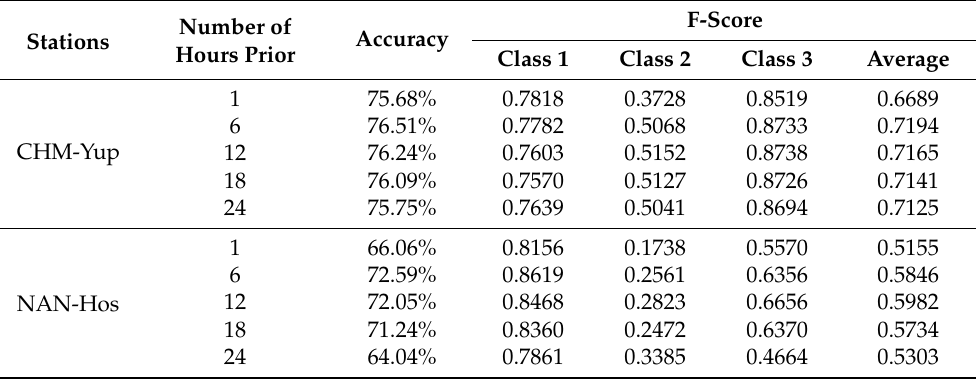
Table 4. Model performance of the transformed dataset with different amounts of historical data to predict hourly PM 2.5 with the three classes of output